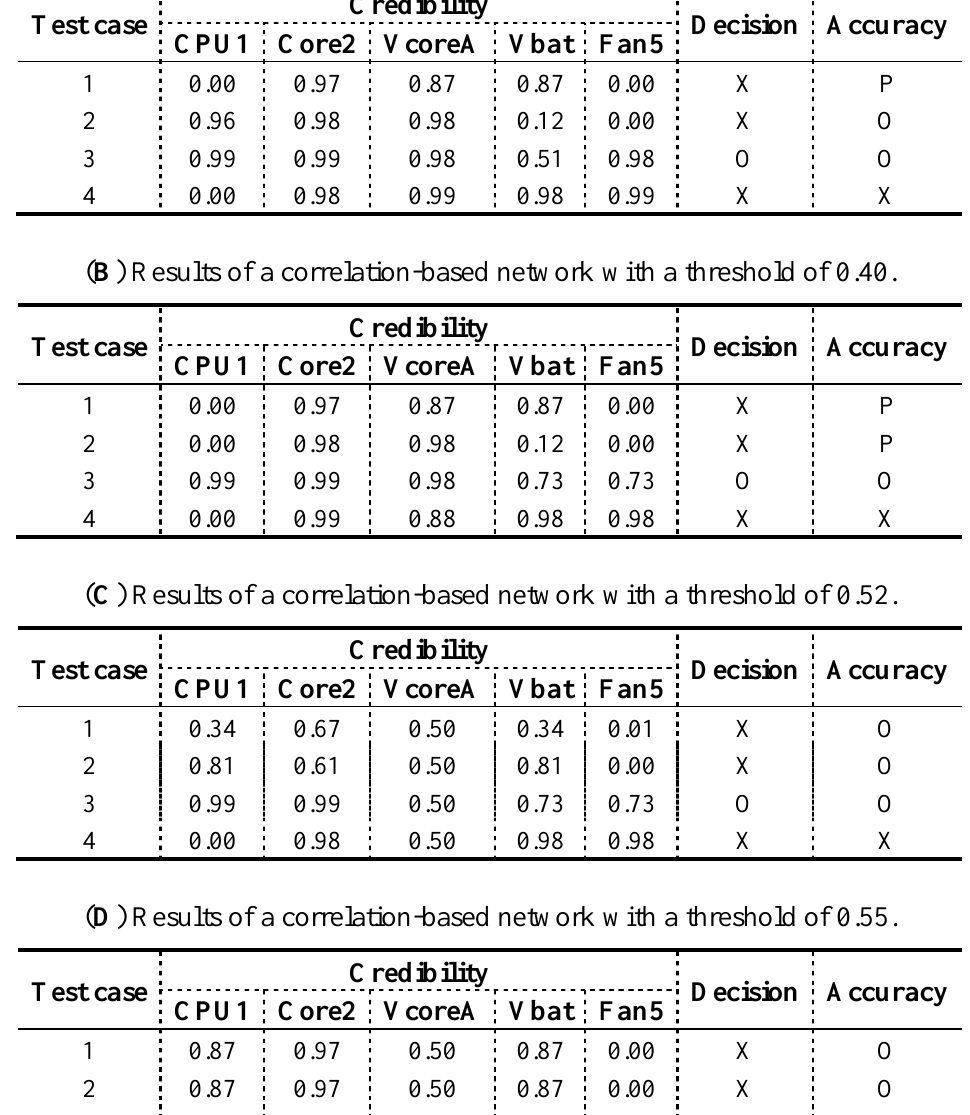
Table 8. ( A ) Results of a correlation-based network with a threshold of 0.01. Test